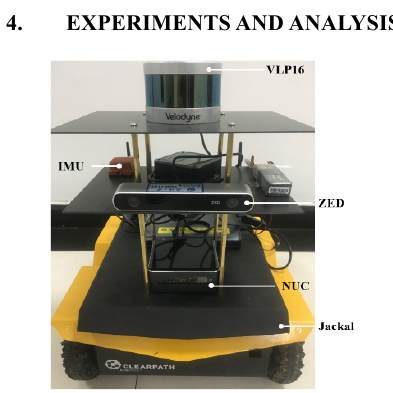
Figure 4. UGV mobile mapping system